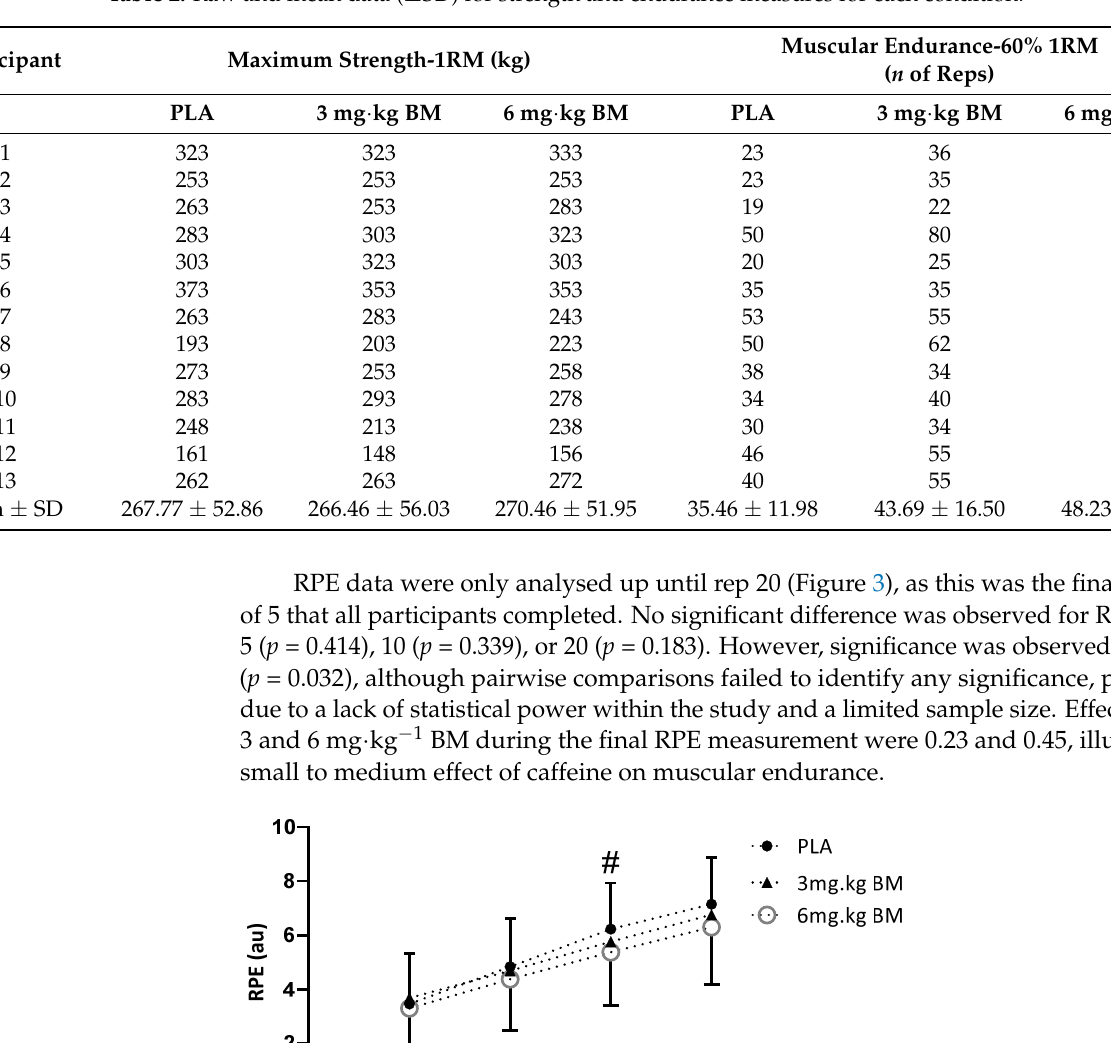
Table 2. Raw and mean data ( ± SD) for strength and endurance measures for each condition.